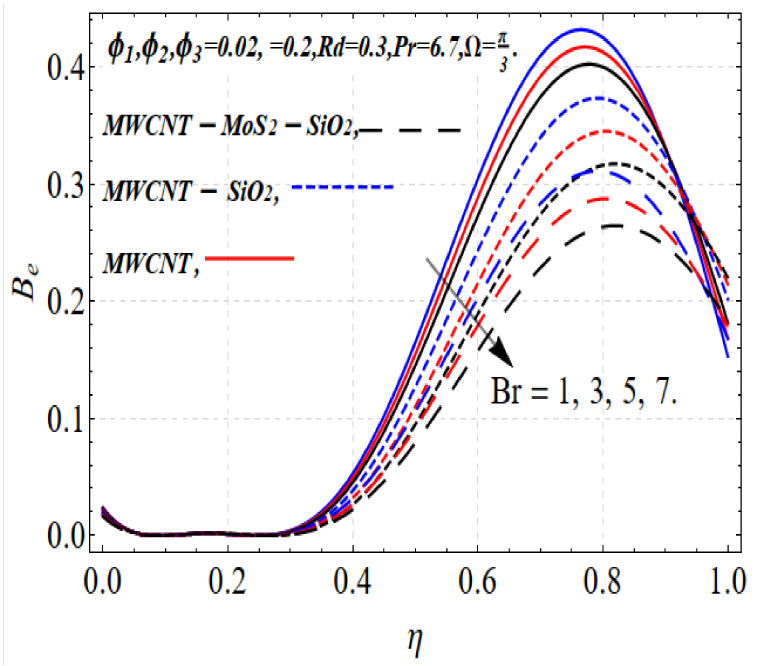
Figure 9. Be vs. Br .